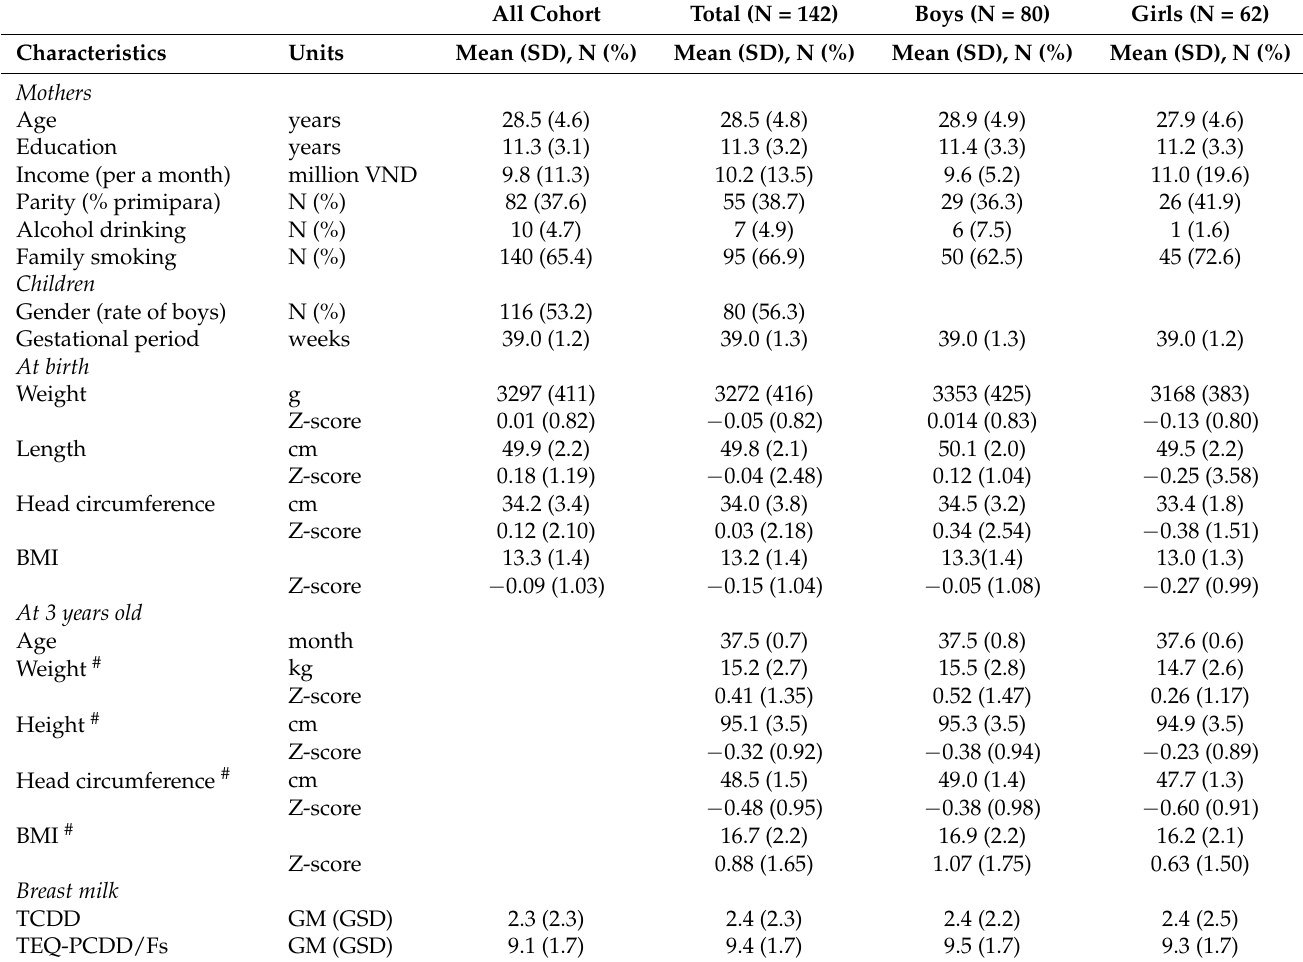
Table 2. Characteristics of mothers and children and perinatal dioxin